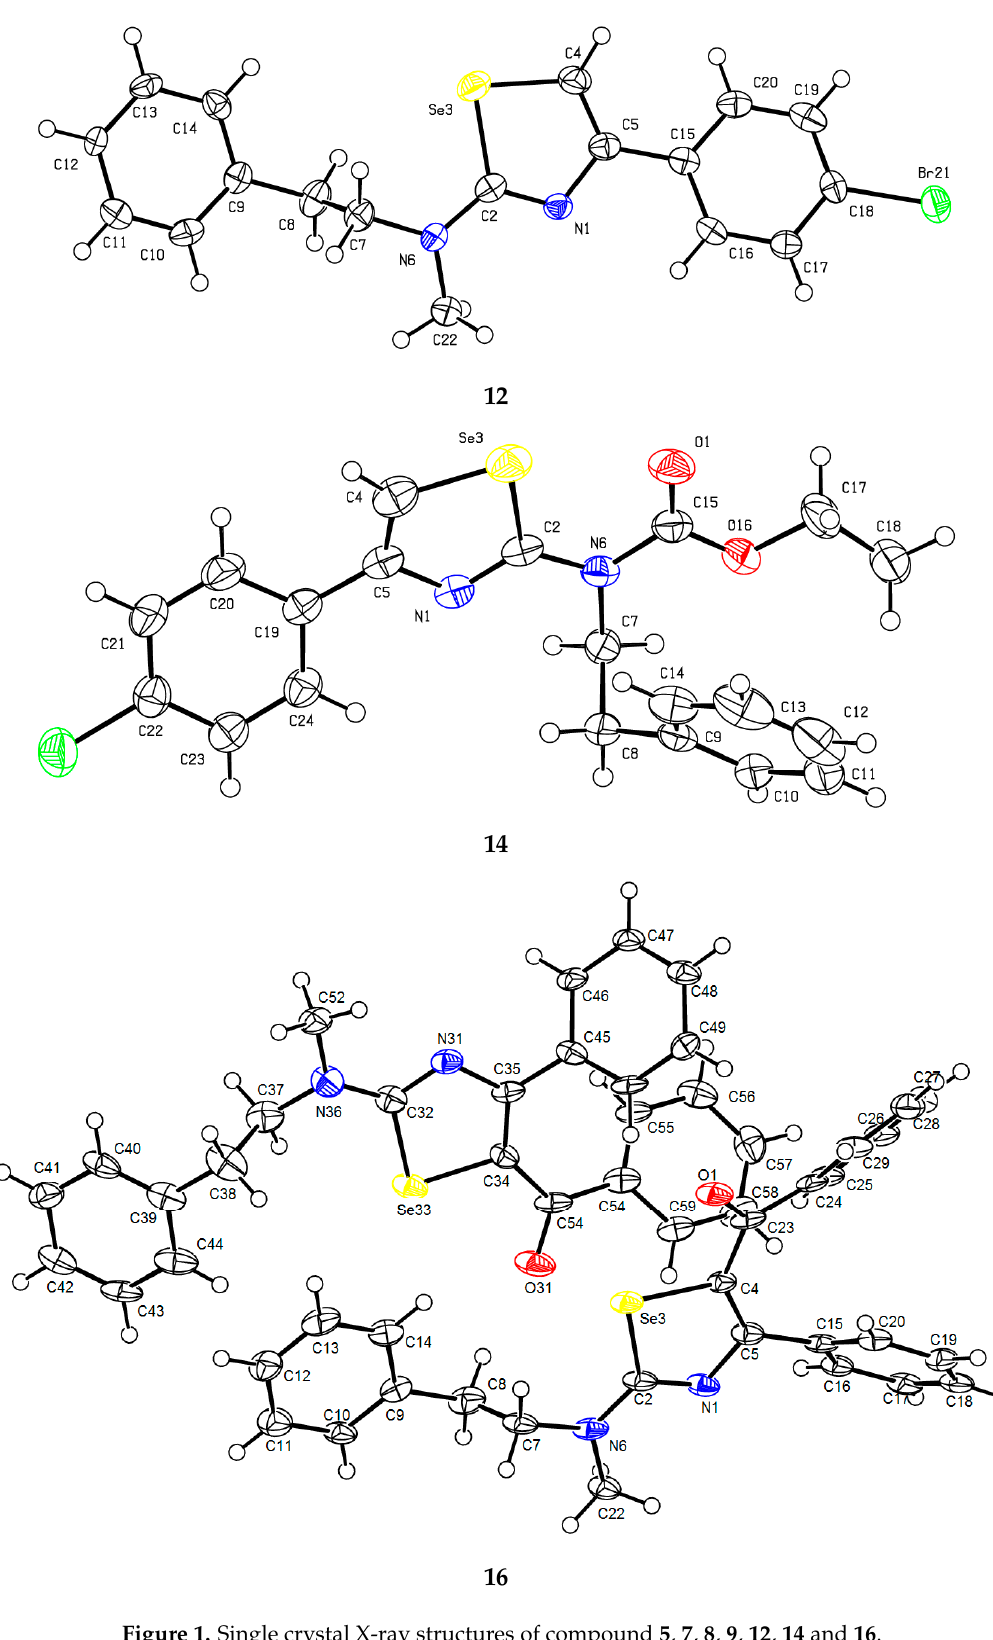
Figure 1. Single crystal X-ray structures of compound 5 , 7 , 8 , 9 , 12 , 14 and 16 .